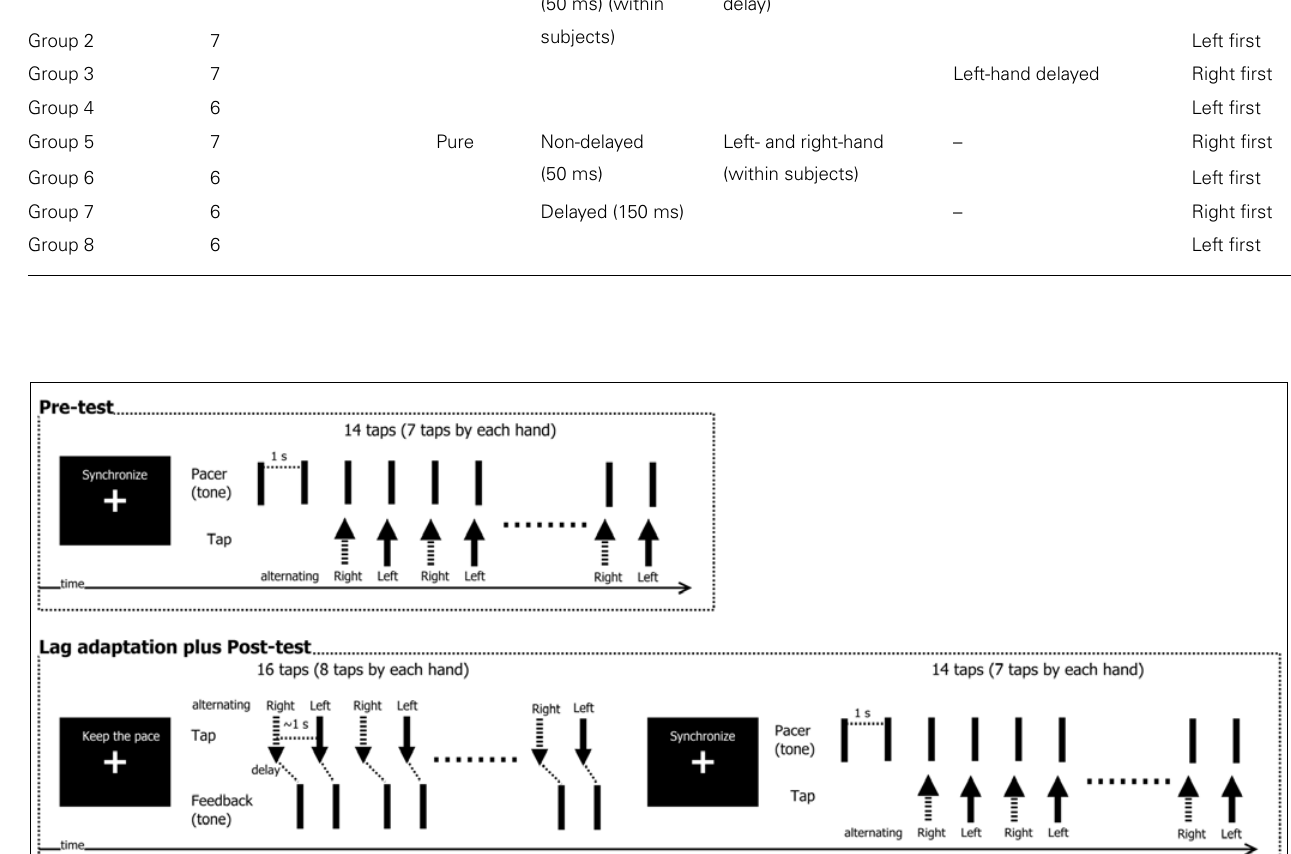
FIGURE 2 | Schematic illustration of the experimental procedure. In the pre-test, participants tried to synchronize left-right finger taps with an isochronous tone sequence. The adaptation/post-test phase consisted of multiple short adaptation phases followed by post-tests. During adaptation, participants made voluntary left-right finger taps